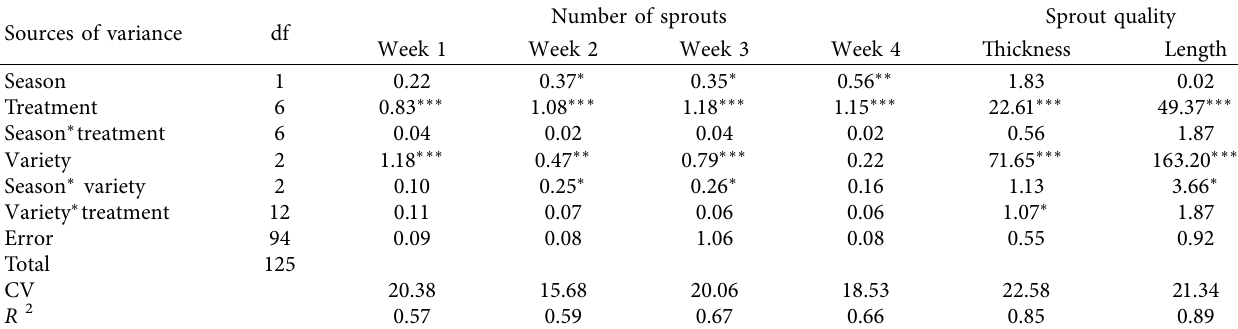
Table 2: The mean squares for a number of sprouts and sprout quality under a greenhouse in the 2019–2020 seasons. Sources of